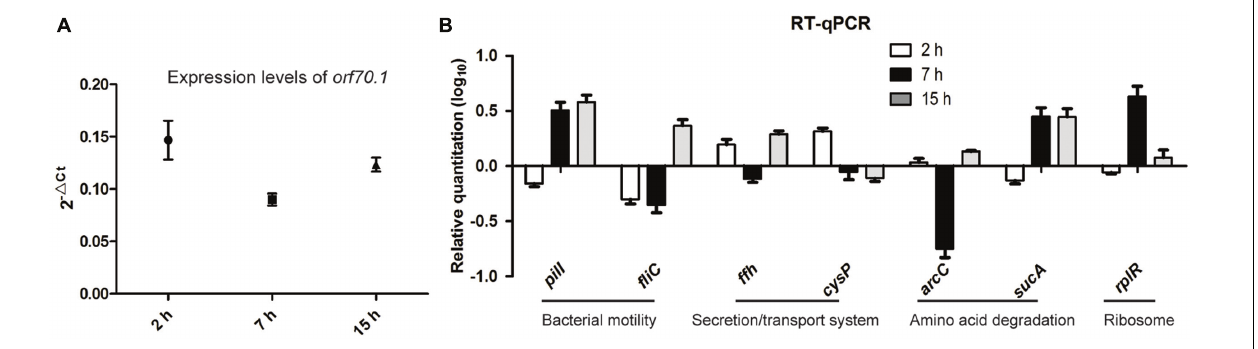
FIGURE 5 | RT-qPCR validation of selected DEGs from microarray data set. (A) Relative expression level of orf70.1 in PA3 was shown with 2 − (cid:77) Ct ( (cid:77) Ct = Ct orf70.1 – Ct 16S rRNA) . (B) RT-qPCR analysis of the selected seven DEGs at the different time point. The qPCR results were normalized using 16S rRNA and expressed as fold change (Log 10 scale) by the comparative Ct method. Control (PA3/pUCP24-2 h, 7 h, and 15 h) is normalized as